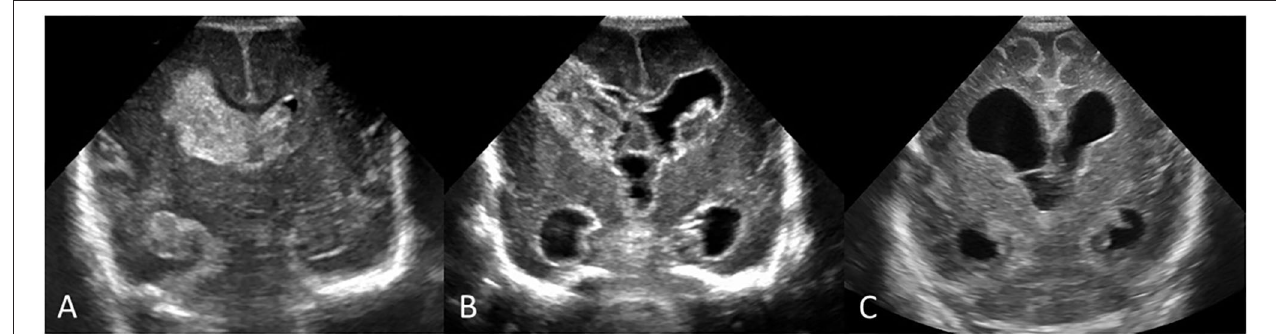
FIGURE 13 | Early and follow up serial cUS scans showing evolution of an acute brain injury in a preterm infant (GA 24 weeks) with bilateral IVH. (A) Coronal scan, at the level of the frontal horns of the lateral ventricles, shows a large acute right-sided GMH-IVH with PVHI and smaller left GMH-IVH. (B) Follow-up coronal scan 2.5 weeks after birth shows IVH evolution with organizing clot and the development of PHVD; note enlarged third ventricle and dilated temporal horns. Hyperechogenic ependyma has developed. (C) Follow-up coronal scan at term-equivalent age shows end-stage pattern effects of earlier injuries with mature right periventricular porencephalic cyst and development of some diffuse cerebral atrophy depicted by widening of convexity cortical sulci and interhemispheric fissure. PHVD has improved, with residual chronic ventriculomegaly likely reflecting a combination of passive enlargement from brain atrophy and impaired CSF resorption pathways from earlier intraventricular